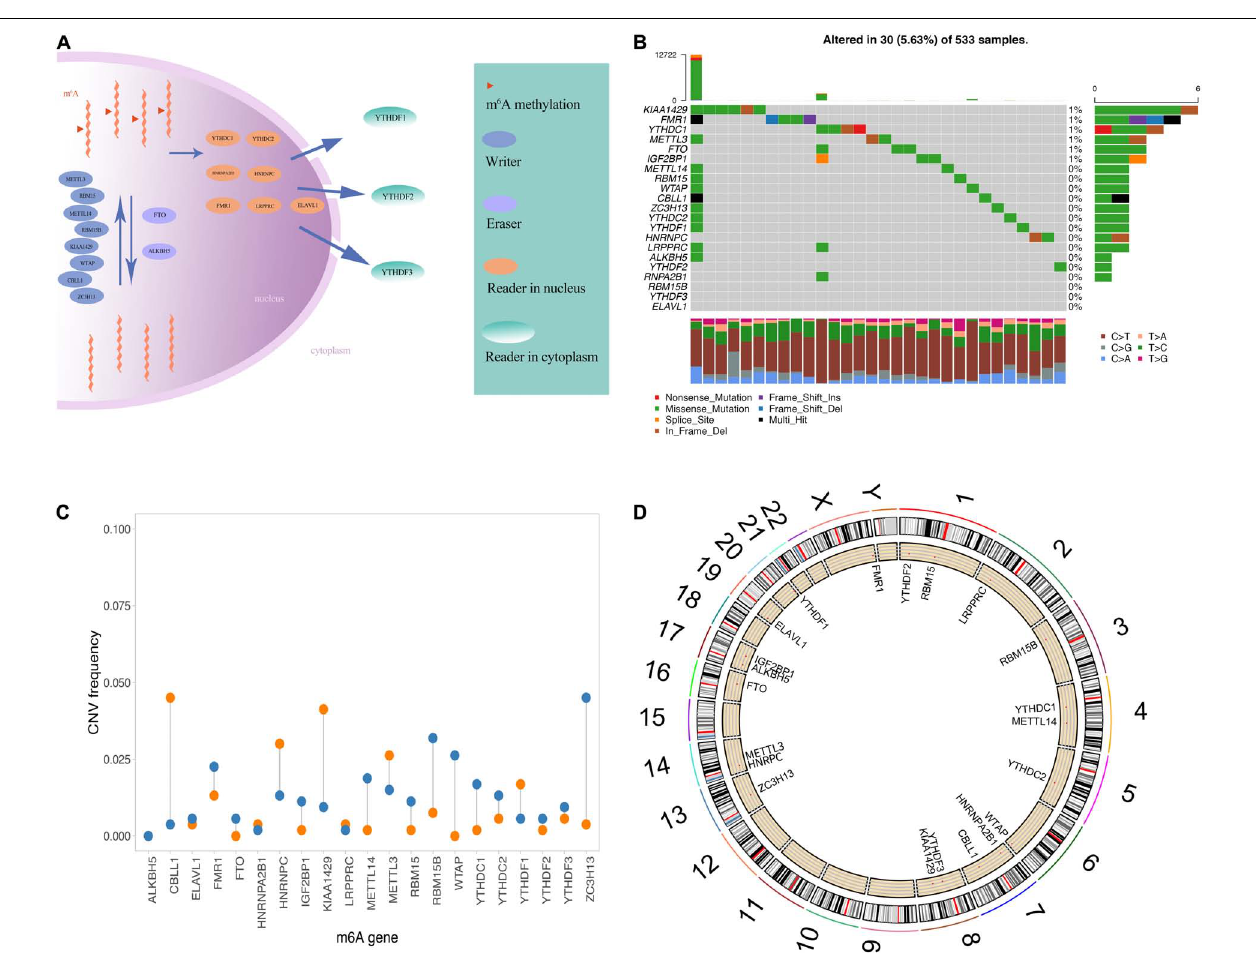
FIGURE 1 | Genetic variation of m6A regulatory factors. (A) Summary of the dynamic reversible process of m6A RNA methylation mediated by regulators (“writers,” “erasers” and “readers”) and their potential biological functions for RNA. (B) The distribution of m6A gene mutations and the distribution of different mutation types. (C) The frequency of CNV occurrence of m6A gene, blue indicates deletion, orange indicates amplification. (D) m6A gene is in Position on chromosome.